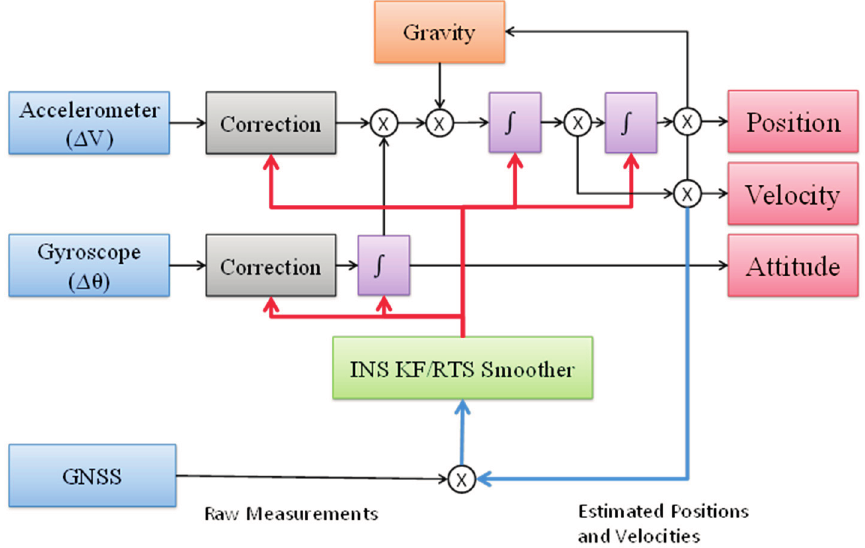
Figure 15. The TC integration